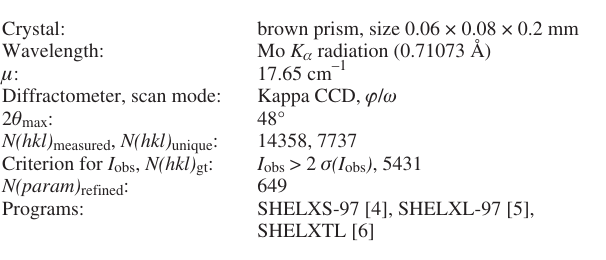
Table 1. Data collection and handling.